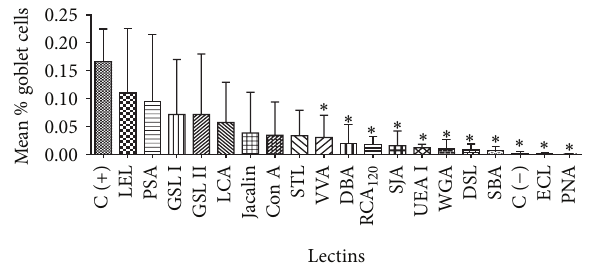
Figure 4: Inhibition of the increase in the percentage of GCs in the respiratory epithelia of nasal septa treated with various lectins. ∗ Significant inhibition ( 𝑃 < 0.05 ) by lectins compared with positive control tissues. C ( − ): negative